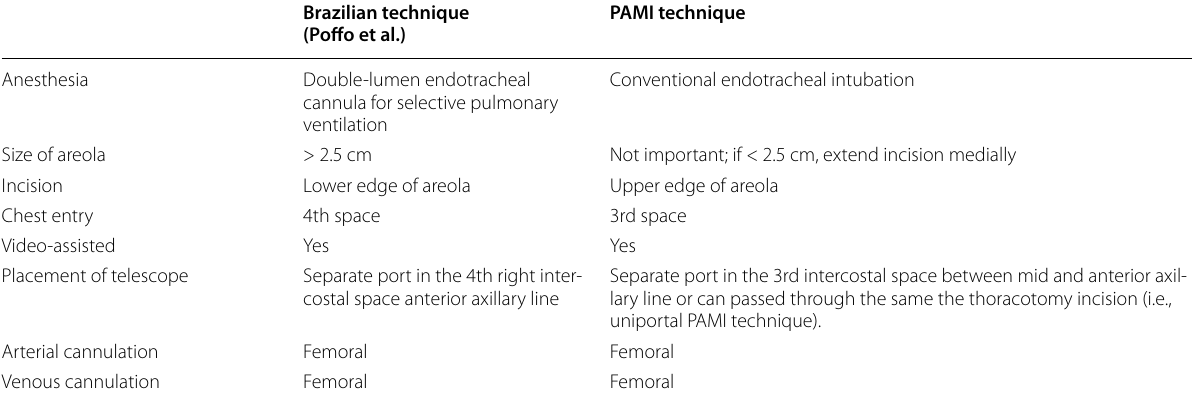
Table 1 Differences between Brazilian periareolar technique and new modification PAMI